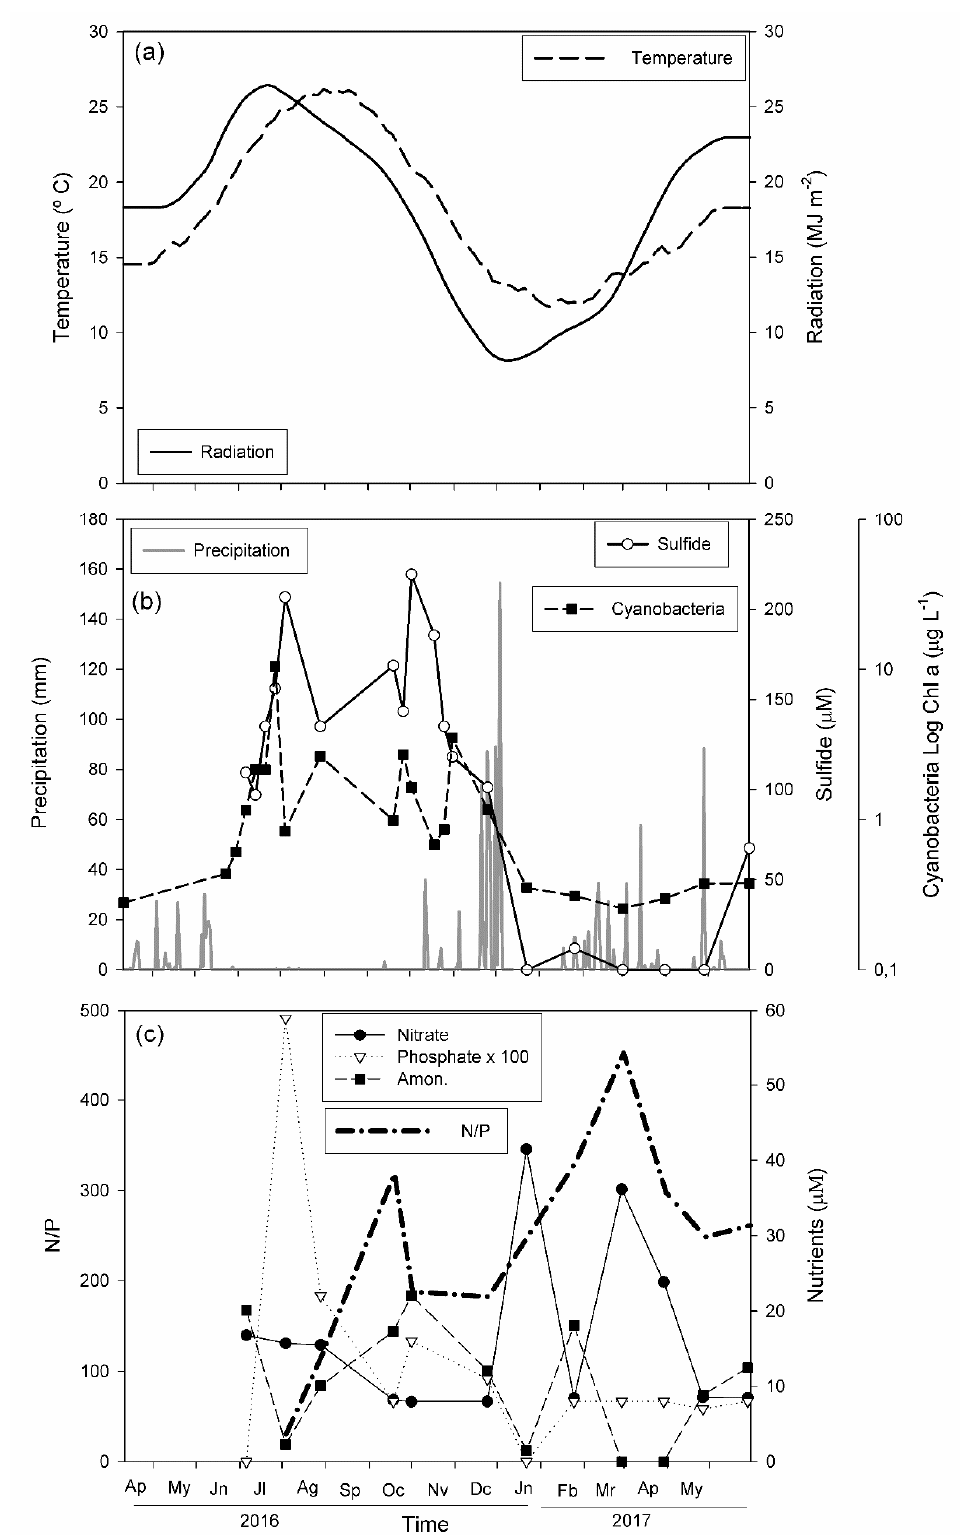
Figure 2. ( a ) Ten-day running mean of solar radiation and air temperature. ( b ) Rainfall at the meteorological sampling station in Estepona; sulfide concentration and cyanobacteria Chl a concentration in La Hedionda water measured at each sampling site. ( c ) Nitrate, ammonia, phosphate concentrations and N / P ((NO 3 − + NH 4 + ) / PO 4 − 3 ) ratio measured in La Hedionda water at each